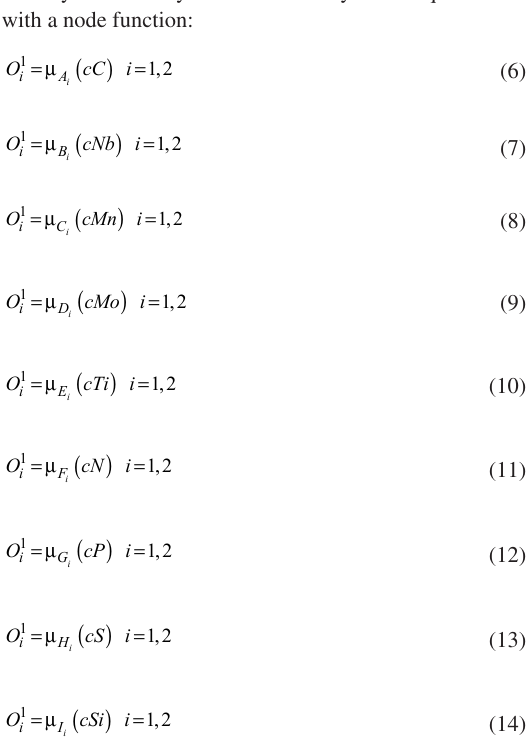
Table 2. The parameters and their range used in the neural network.